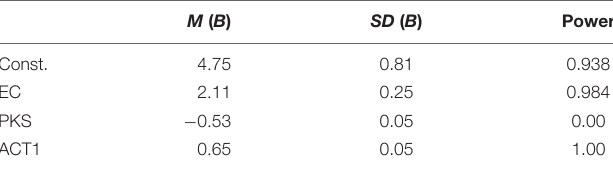
TABLE 5 | Results of the Monte Carlo simulation, Study 1, LM2.